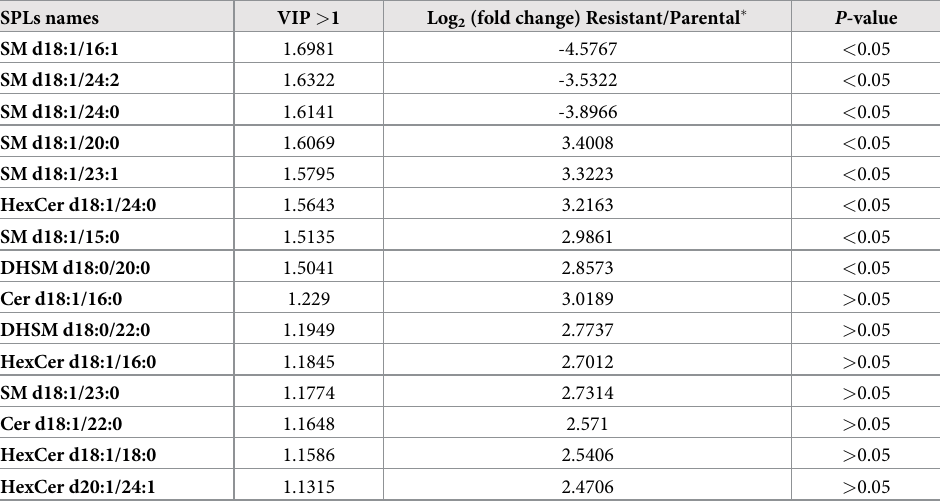
Table 3. VIP scores of SPLs (VIP > 1) in parental MCF-7 and dox-resistant cell lines.